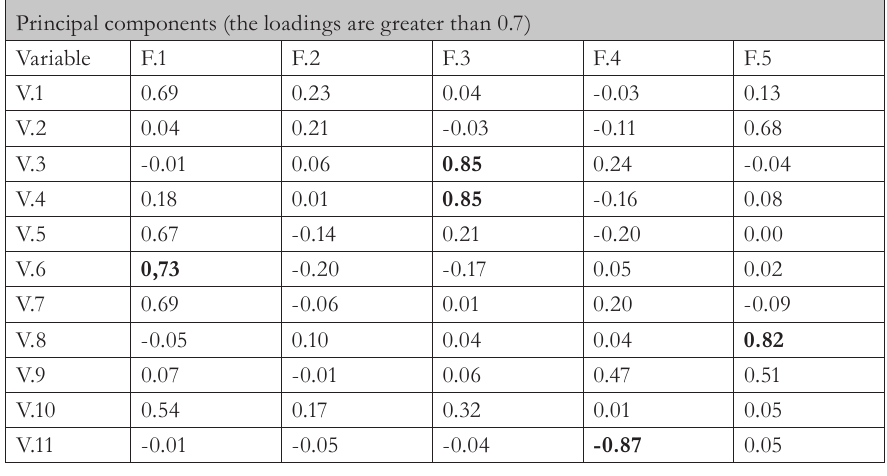
Tab. 4 – Matrix of factor loadings for factors of enterprise competitiveness dependent on